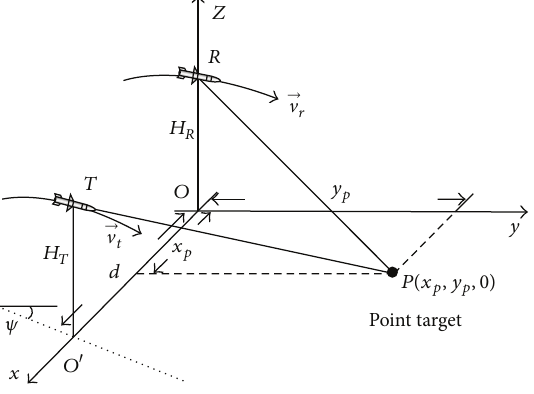
Figure 2: Geometric configuration of